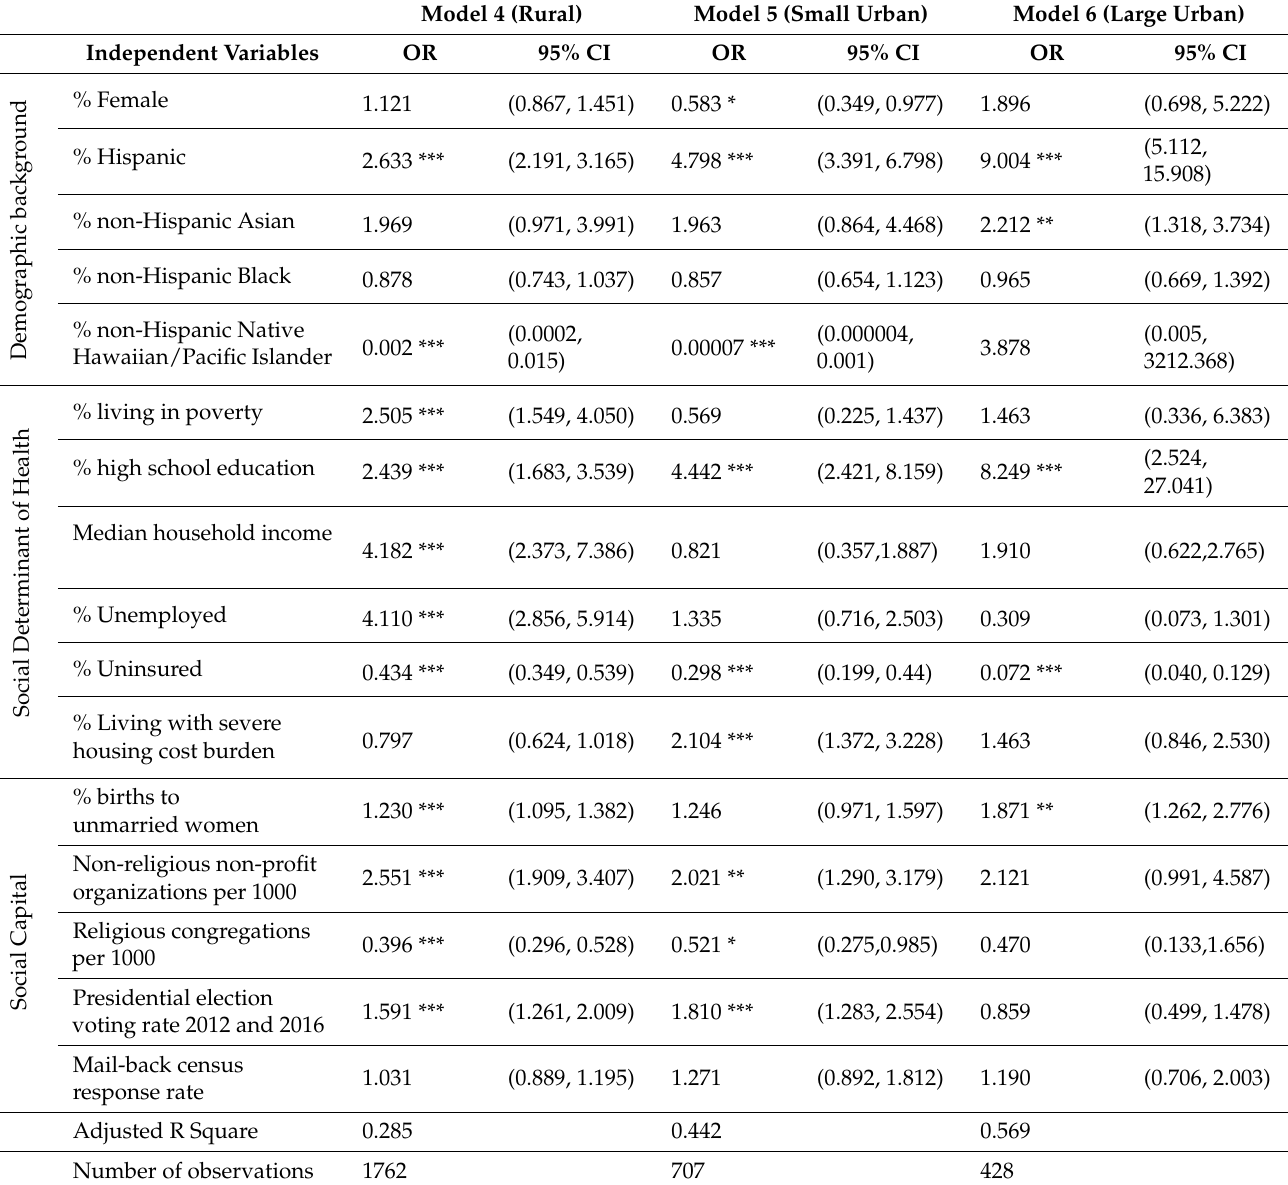
Table A4. Regression results when stratified by urbanization